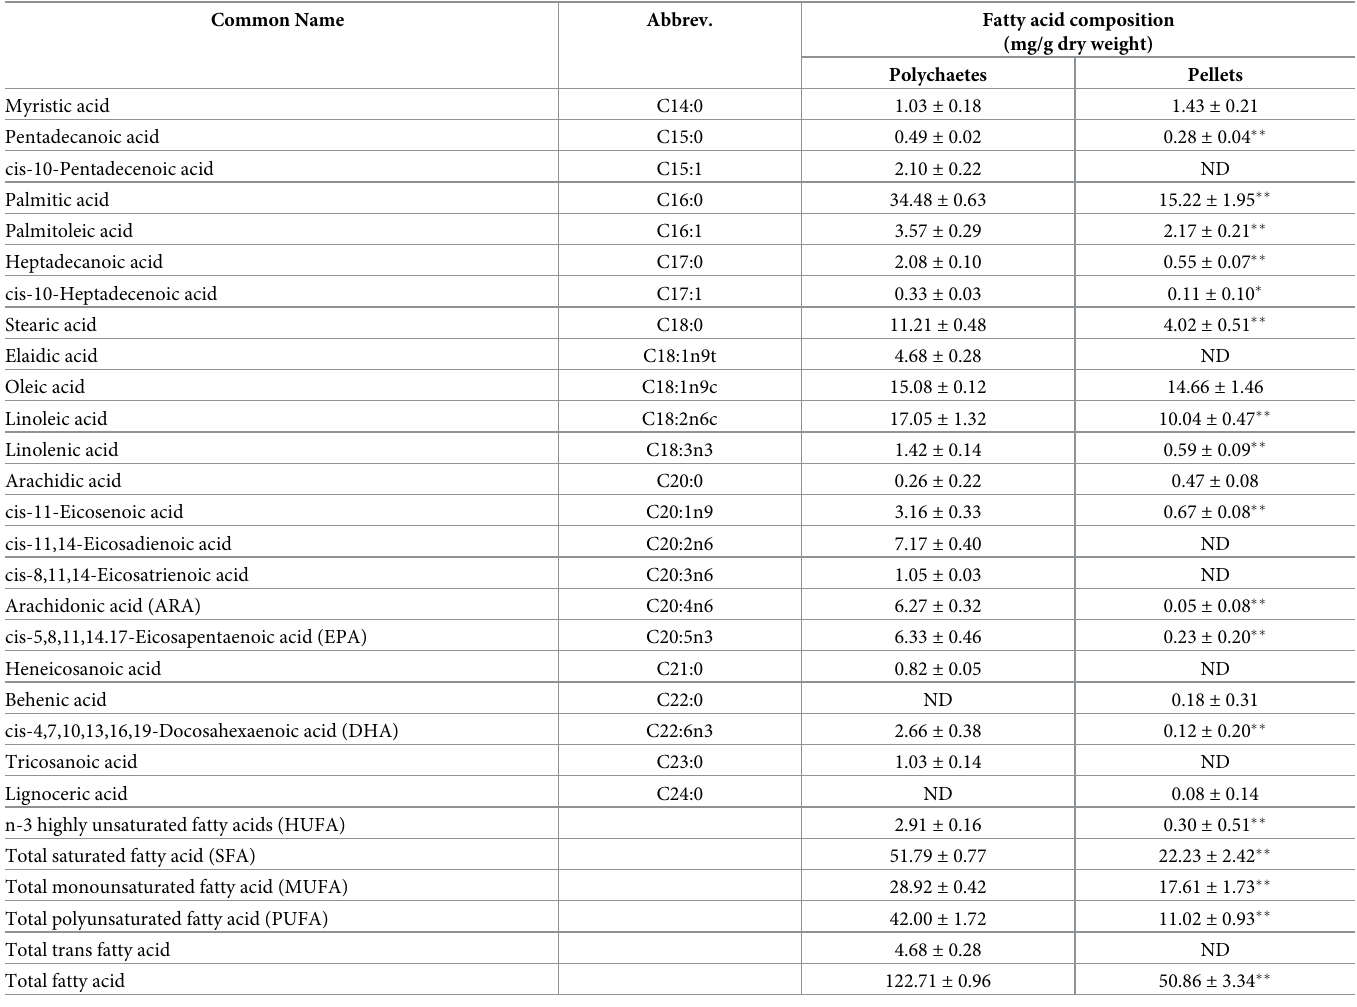
Table 1. Fatty acid compositions in mg per g dry weight of polychaetes and feed pellets.